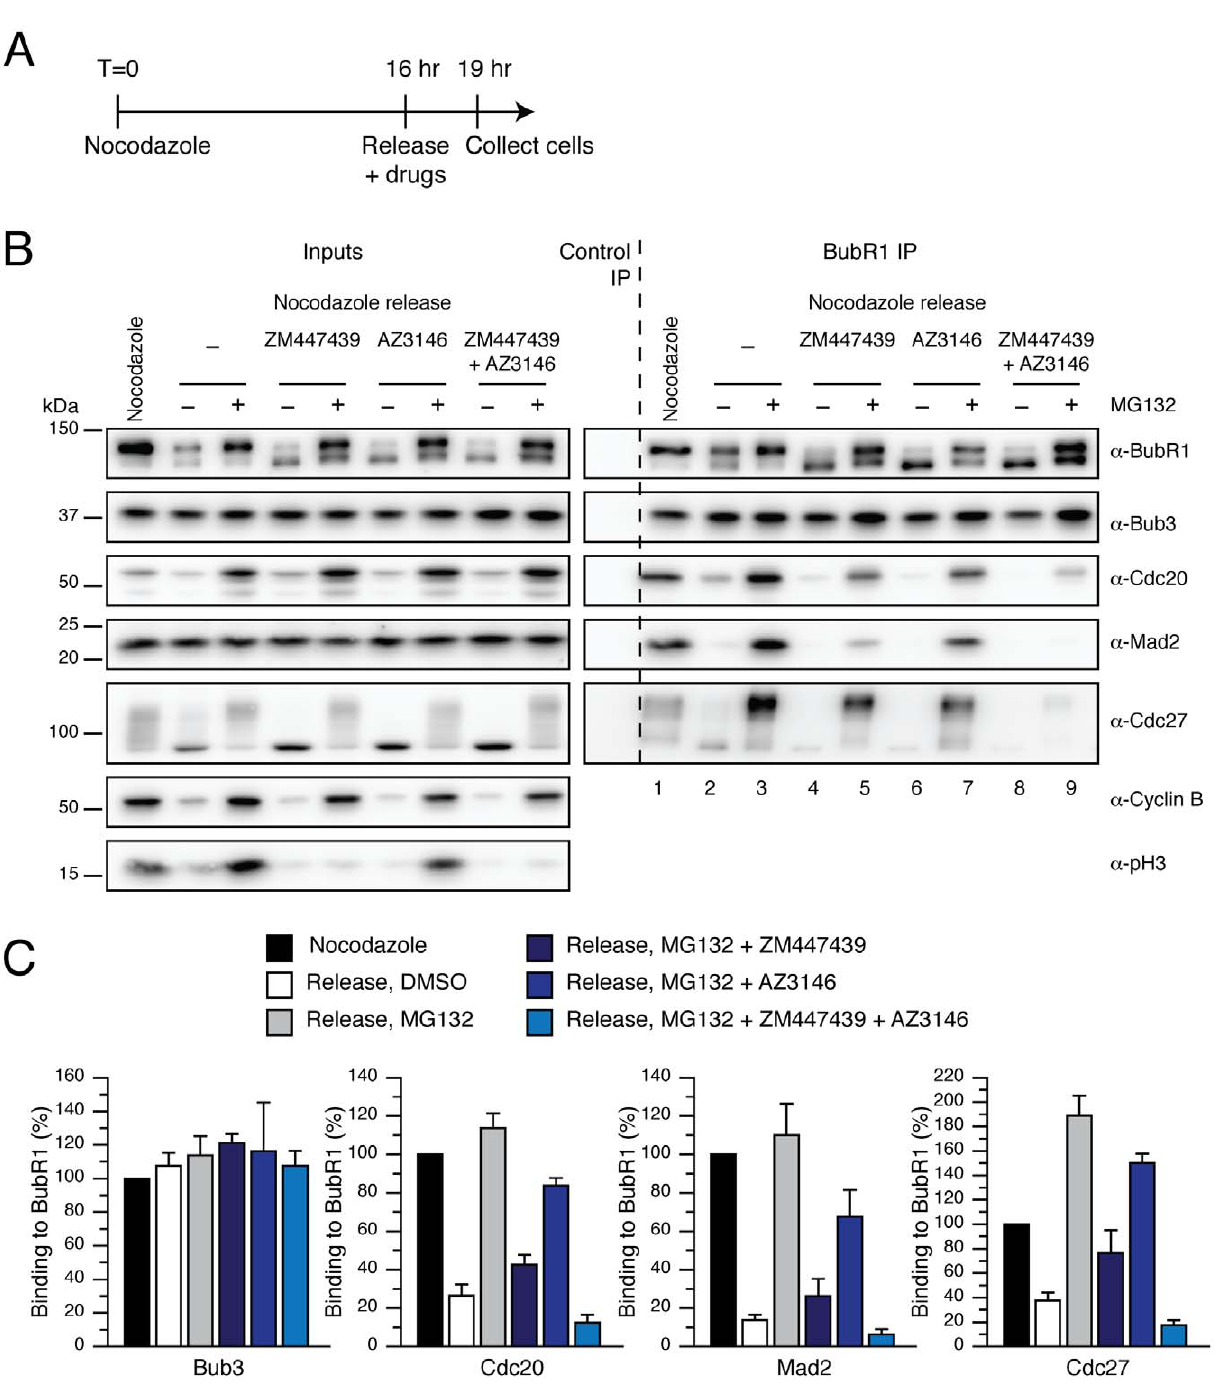
Figure 4. Inhibition of cohesion fatigue promotes MCC disassembly, even when the proteasome is inhibited. ( A ) Timeline showing the experimental strategy. ( B ) Immunoblots of BubR1 immunocomplexes isolated from HeLa cells. Cells were treated with Wapl RNAi, synchronised with a single thymidine block and then released into media containing nocodazole for 12 hours before being selectively detached and released into normal media or media containing MG132 for 3 hours. Cyclin B was used as a mitotic marker. ( C ) Bar graph quantifying the experiment in (B). Values represent the mean 6 s.e.m. of three independent experiments, each analysed twice. P values were calculated using paired, two-tailed t -test.